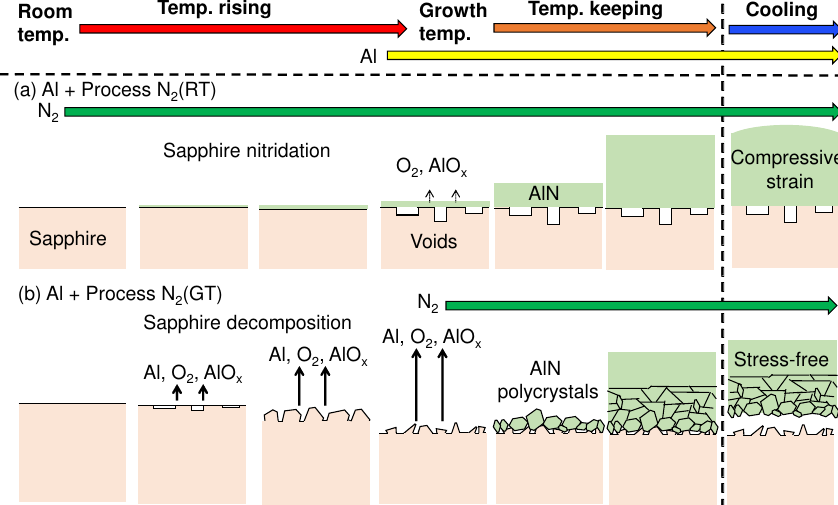
Figure 6. Proposed interface formation mechanisms in the elementary source vapor phase epitaxy (EVPE) growth with Al + Processes ( a ) N 2 (GT) and ( b ) N 2 (RT).